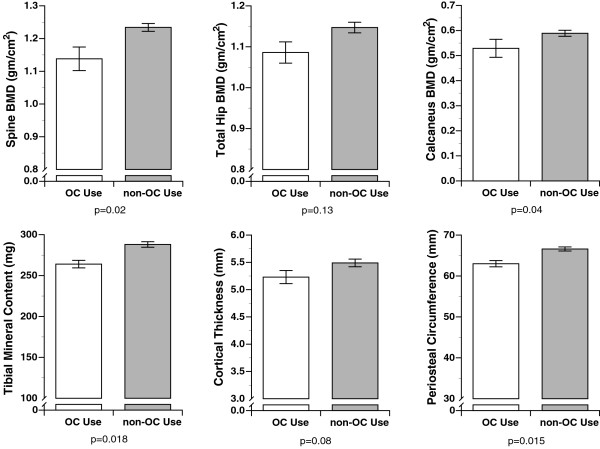
The impact of oral contraceptive use on bone mass and size. Oral contraceptive use was defined as OC use for at least three months versus never users. Bone mineral density was measured in these two groups at the spine, hip and heel; at the tibia, bone mineral content, cortical thickness and periosteal circumference were measured. All values are mean ± standard errors.